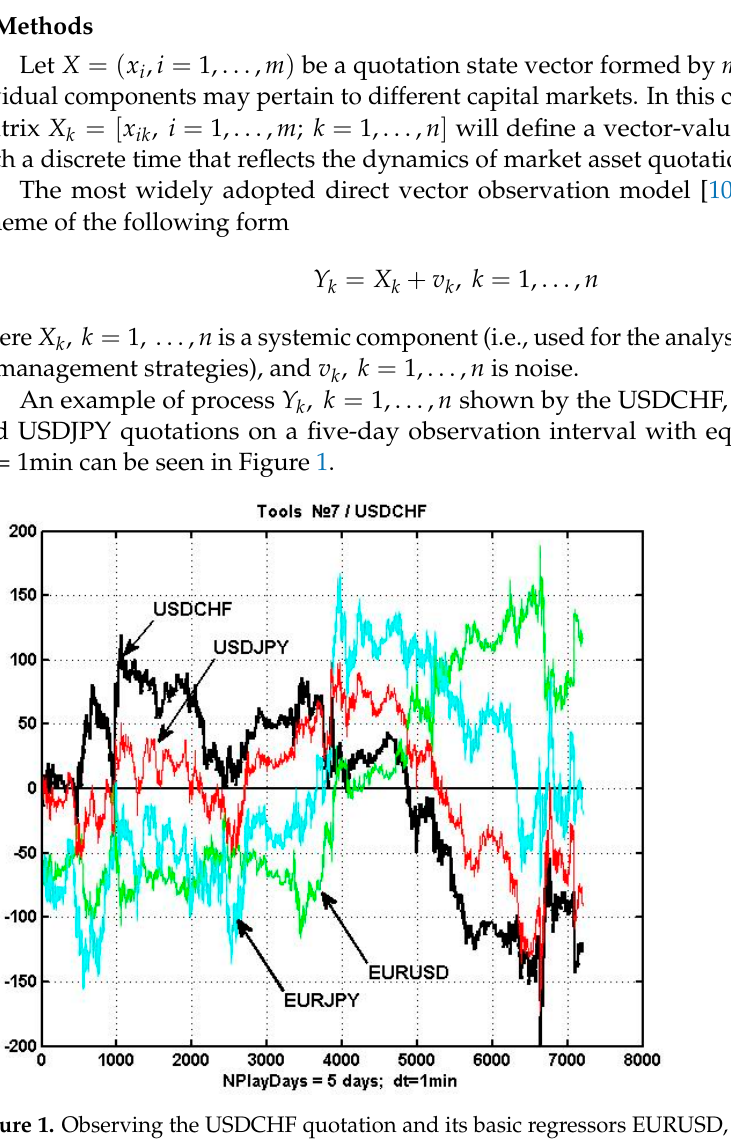
Figure 1. Observing the USDCHF quotation and its basic regressors EURUSD, EURJPY, and USDJPY on a five-day observation interval.